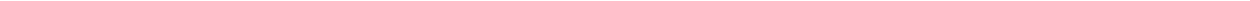
Figure 3 | Palbociclib synergizes with autophagy inhibition in vivo . ( a ) Percentage change in tumour volume (normalized to Day 0) upon treatment with vehicle or palbociclib ( n Z 4 tumours per group) daily for 7 days. Tumours were then harvested for ( b ) Tumour weight measurement, ( c ) western blot of cell cycle (phospho-Rb, Rb, FOXM1) and autophagy (LC3B, p62) proteins, ( d ) TEM analysis (red arrows indicate double-membraned autophagosomes; Scale bars, 500nm) and ( e ) BrdU, 8-OHdG and SA- (cid:2) gal staining (Scale bars, 50 m m). ( f , g ) Percentage change in mean ( f ) or individual ( g ) tumour volumes (normalized to Day 0) upon treatment with Vehicle, 25mgkg (cid:2) 1 palbociclib, 60mgkg (cid:2) 1 HCQ or combination of palbociclib (25mgkg (cid:2) 1 ) and HCQ daily for 21 days (treatment phase) and recovery for 21 days (recovery phase) ( n Z 8 tumours per group). Data represented as mean ± s.e.m. Tumours were harvested for ( h ) tumour weight measurement at end of treatment þ recovery phase ( n Z 6 for each group), ( i ) western blot of cell cycle (phospho-Rb, Rb) and autophagy (LC3B, p62) proteins, ( j ) RPPA analysis and Pathway score of proteins in the cell cycle ( n ¼ 10) and senescence ( n ¼ 13) pathways (Error bars represent maximum and minimum values) and ( k ) BrdU, 8-OHdG and SA- (cid:2) gal staining with representative images end of recovery phase and quantitation (Scale bars, 50 m m). ( l , m ) Percentage change in mean ( l ) or individual ( m ) tumour volumes (normalized to Day 0) upon treatment with Vehicle, 5mgkg (cid:2) 1 palbociclib, 10mgkg (cid:2) 1 Lys-05 or combination of palbociclib and Lys-05daily for 21 days (treatment phase) and recovery phase of 14 days. Data represented as mean ± s.e.m. n Z 5 for each group. ( n ) Kaplan–Meier survival curve with death and tumours exceeding 1,000mm 3 as end point upon treatment as in ( l ). n Z 5 for each group. All data are represented as mean ± s.d. and P values were calculated in comparison to mice treated with vehicle unless indicated. NS: P 4 0.05; * P o 0.05; ** P o 0.01; *** P o 0.001; **** P o